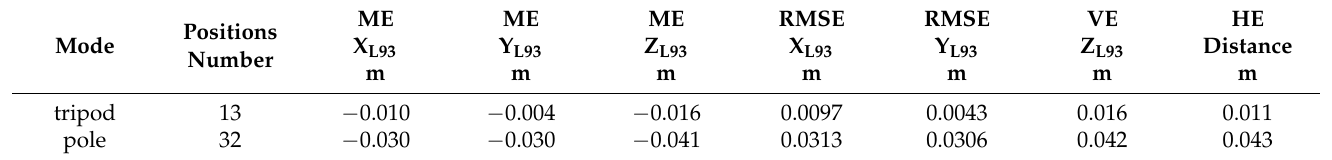
Table 5. Mean error (ME), root mean square error (RMSE), vertical error (VE) and horizontal error (HE) on X,Y,Z Chavenay II geodesic point coordinates, measured with a Trimble Geo7x GNSS receiver in tripod and pole mode. RGF93 Lambert 93 coordinate system.